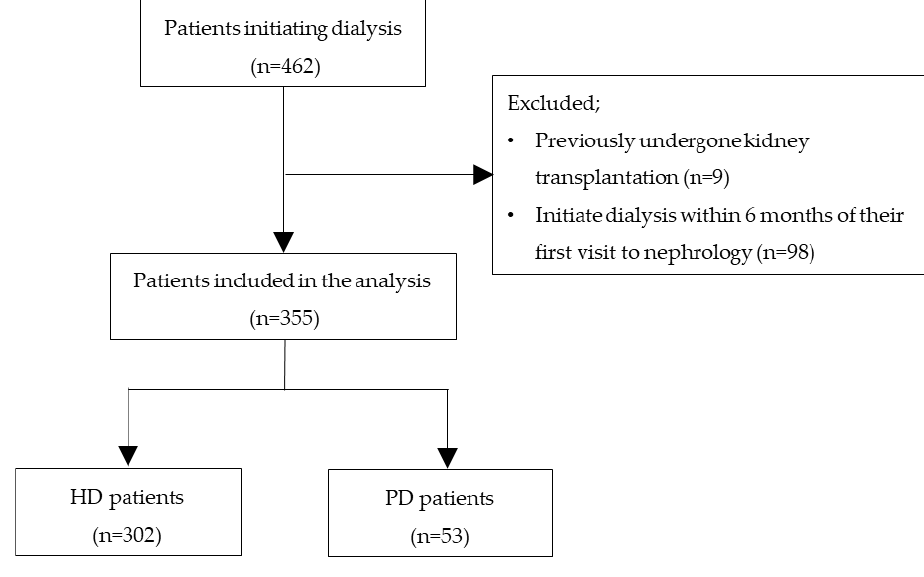
Figure 1. Flow chart of the present study. Table 1. Patients’ baseline characteristics in groups with HD and PD.